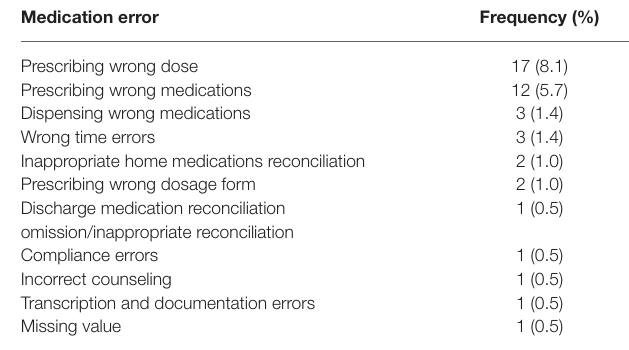
TABLE 4 | Reported MEs by the HCPs.